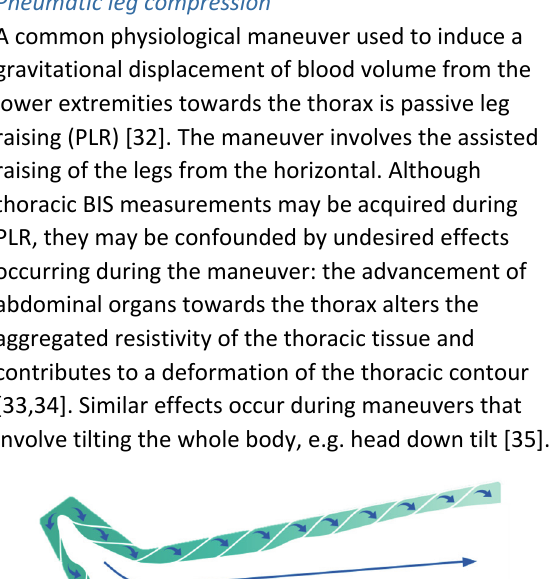
Figure 2. Leg compression and measurement protocol. The blue line is a qualitative representation of the pressure applied to the legs: the up-slope marks the gradual pressure build-up during the inflation of the leg sleeves; the downward step marks the pressure drop in the air chambers as the valves are opened for deflation. The black line represents the continuous BIS measurement, black rectangles indicate the four periods of end-expiratory breath-hold used in the analysis. (BIS = bioimpedance